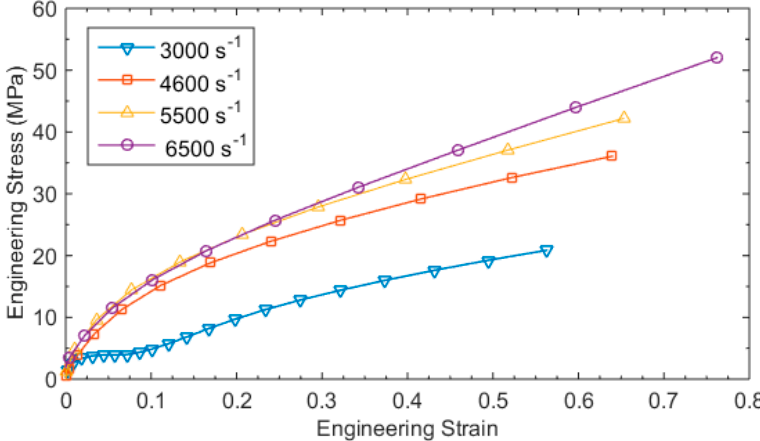
ff erent strain